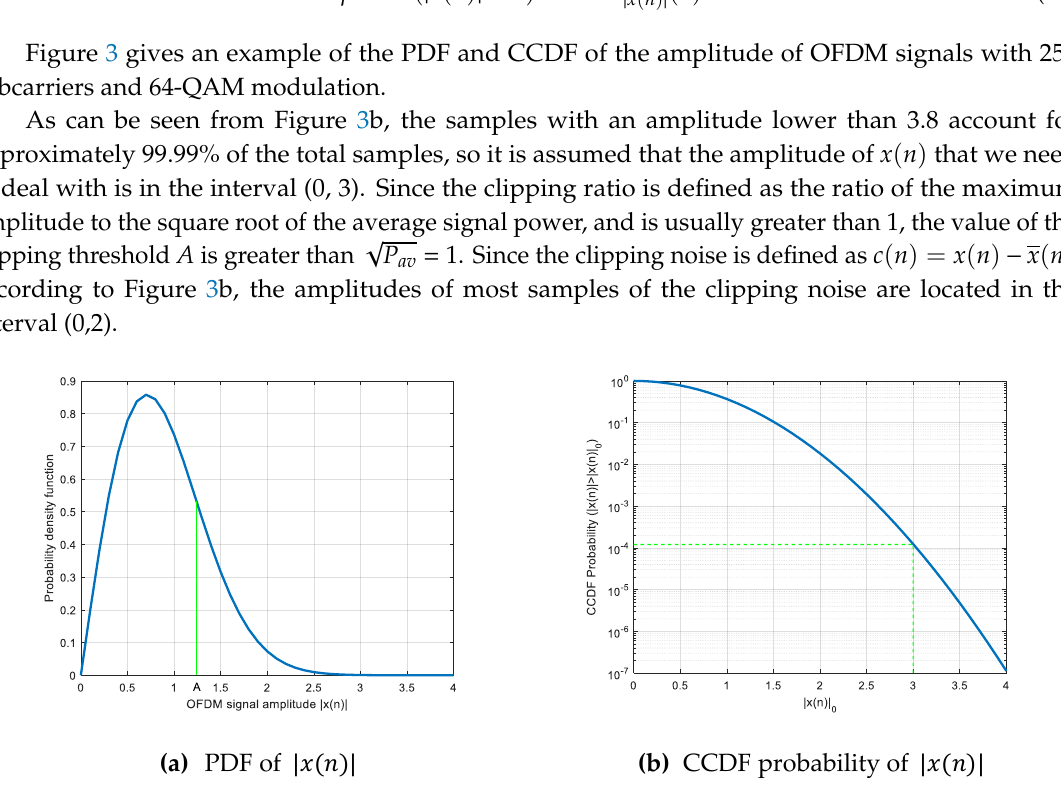
Figure 3. An example of the probability density function (PDF) and complementary cumulative distribution function (CCDF) of the amplitude of an orthogonal frequency division multiplexing (OFDM) signal.